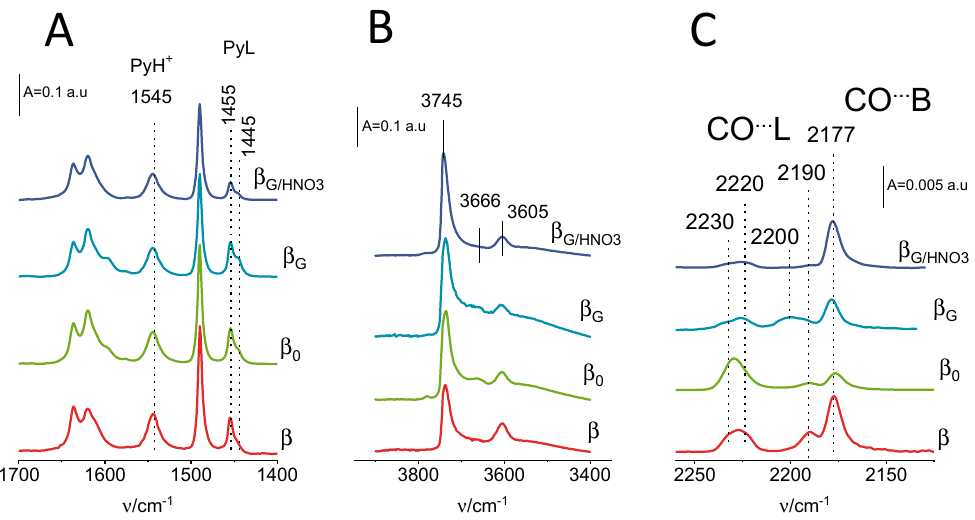
Figure 3. IR spectra of zeolites studied collected ( A ) during quantitative Py sorption studies, ( B ) in the region of O–H stretching vibrations. and ( C ) during the saturation of Lewis acid sites with carbon monoxide.